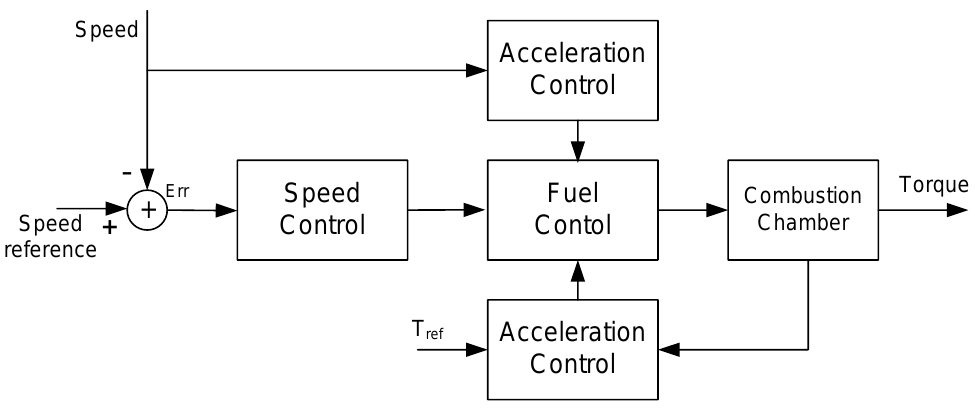
Figure 1. A block diagram of a charging station based on MGT and a supercapacitor.